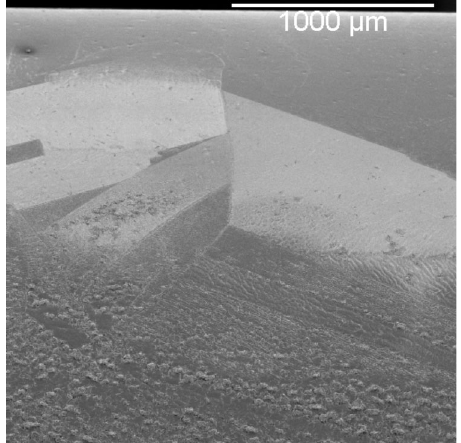
FIG. 21. SEM micrograph showing detail of inner rod pulsed heating